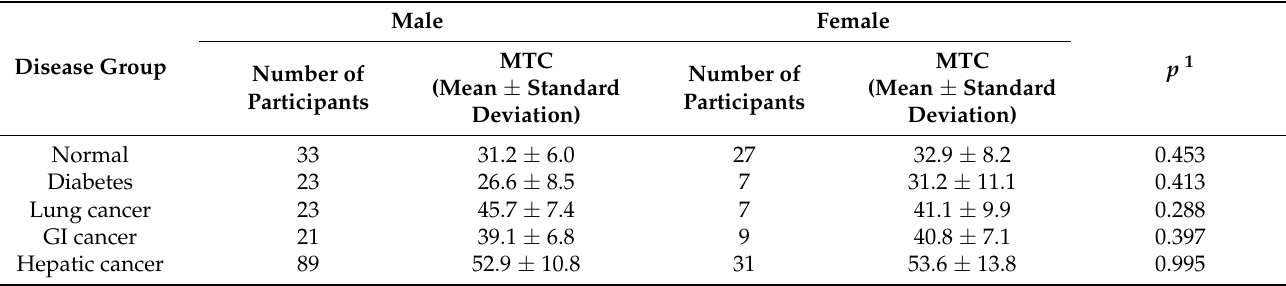
Figure 3. UIBC in different disease groups. ( A ) Distribution of UIBC among normal subjects and patients with different types of disease. The boxes indicate interquartile ranges (IQRs) and the median (middle line). Whiskers extend to the most extreme points within 1.5-fold IQR. Outliers are plotted individually as dots. * represents p values derived from Games–Howell test for multiple comparisons that are less than 0.05. ( B ) Distribution of subjects with different diseases in four quartile intervals of apo-Tf obtained from UIBC assay. Q1, Q2 and Q3 illustrate the first (19.369), second (27.287) and third quartiles (36.057) of UIBC, respectively. Table 1. Comparisons of MTC between males and females in each disease group.